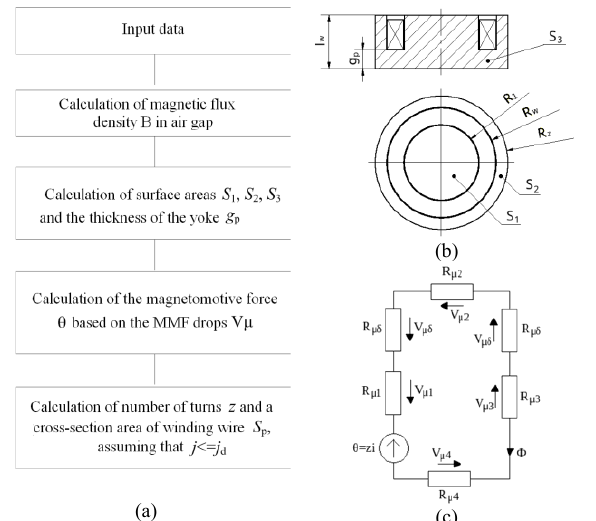
Fig. 1. Elaborated algorithm (a), geometric dimensions (b) and magnetic circuit (c) of the axis-symmetric gripper , where B – magnetic flux density, S1 – surface area of the cylinder, S2 – surface area of the ring, S3-surface area of the cross-section, R1-cylinder radius, Rw- inner ring radius, Rz- outer ring radius, gp- thickness of the base, lw- height of the gripper.